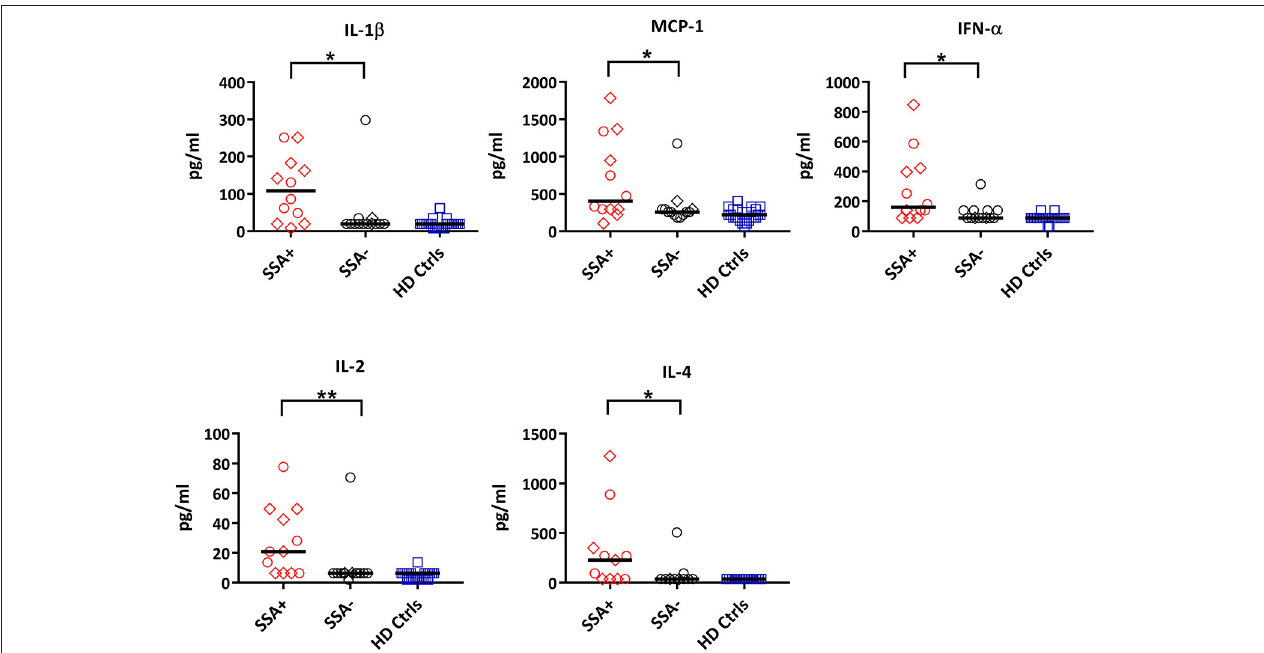
FIGURE 6 | Differential expression of cytokines between autoantibody positive (SSA + ) and autoantibody negative (SSA-) pSS patients. Cytokine profiles were measured by 25-plex Luminex assay in plasma. Cytokine levels (pg/ml) showing significant differences between SSA + patients (red) and SSA– patients (black) are shown. Healthy controls (HD Ctrls) are shown in blue. Medicated patients are shown as diamond. Comparison between pairs was done by unpaired Mann-Whitney test between the two patient subgroups. Differences were considered statistically significant for p ≤ 0.05, with significance being indicated as * ≤ 0.05, ** ≤ 0.01. The median is indicated. The data represents pSS patients ( n = 25) grouped into SSA + patients ( n = 12) and SSA– patients ( n = 13) (except for IL-4, n = 11 in each